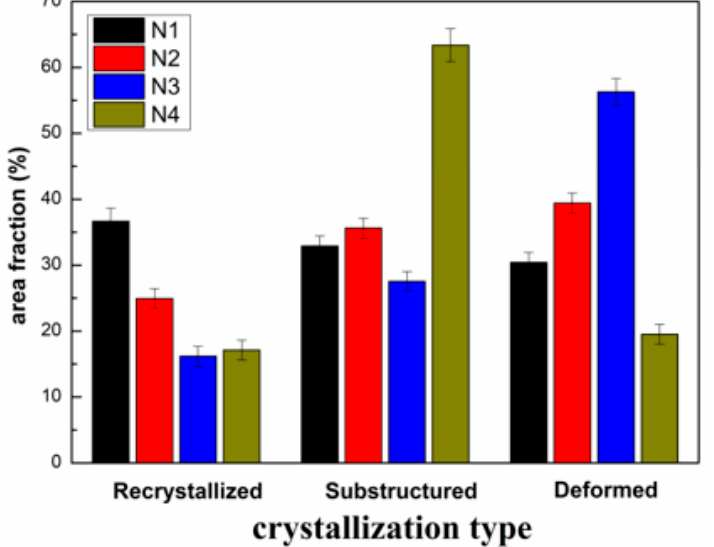
Figure 7. Recrystallized fraction component of ( a ) N1, ( b ) N2, ( c ) N3 and ( d ) N4.